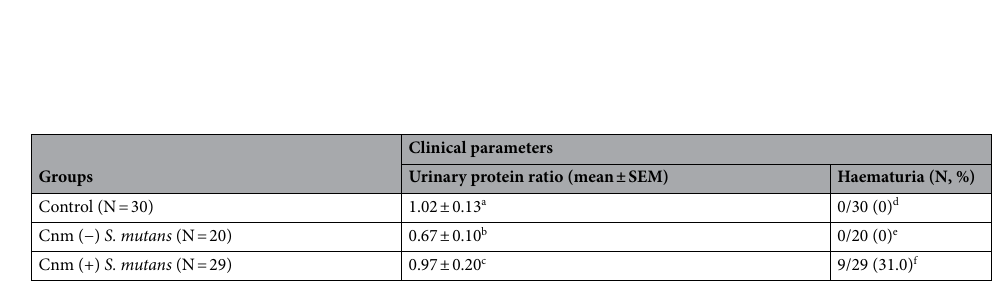
Table 1. Analysis of urine components in rats inoculated with Cnm-positive and Cnm-negative S. mutans . a– c Statistical significance was determined using analysis of variance with Bonferroni’s correction. d–f Statistical significance was determined using Fisher’s exact test ( d,f P < 0.001 and e,f P < 0.001). SEM, standard error of the